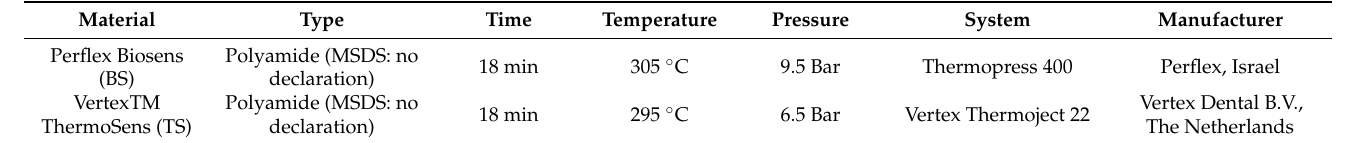
Table 2. Materials, modified technological parameters, and manufacturer.